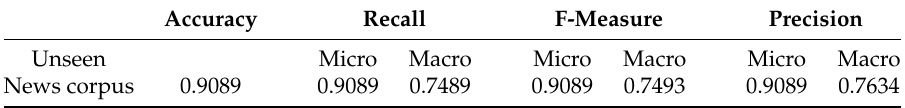
Table 5. Results of geographic category disambiguation over a news corpus with 1956